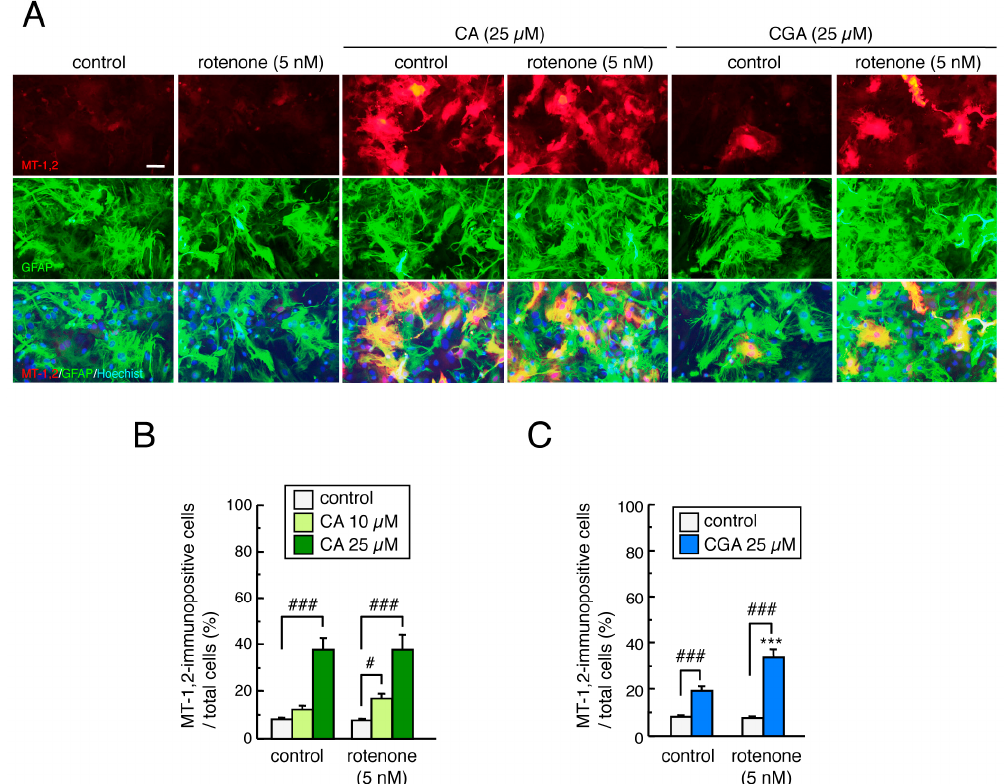
Figure 6. Effects of treatment with CA or CGA followed by rotenone exposure on MT-1,2 expression in mesencephalic astrocyte cultures. Astrocyte cultures were pretreated with CA (10 or 25 µ M) or CGA (25 µ M) for 24 h and co-treated with rotenone (1–5 nM) for a further 48 h. ( A ) Representative photomicrographs of MT-1,2 and GFAP double immunostaining in astrocyte cultures. Red: MT-1,2-positive signals. Green: GFAP-positive astrocytes. Blue: nuclear staining with Hoechst 33342. Scale bar = 50 µ m. ( B , C ) Quantitation of MT-1,2-positive signals in astrocyte cultures after treatment with rotenone and CA ( B ) or CGA ( C ). Each value is the mean ± SEM (n = 8–13) expressed as the percentage of the MT-1,2-immunopositive astrocytes in the total cell population. *** p < 0.001 vs. each control group, # p < 0.05, ### p < 0.001 between the two indicated groups.